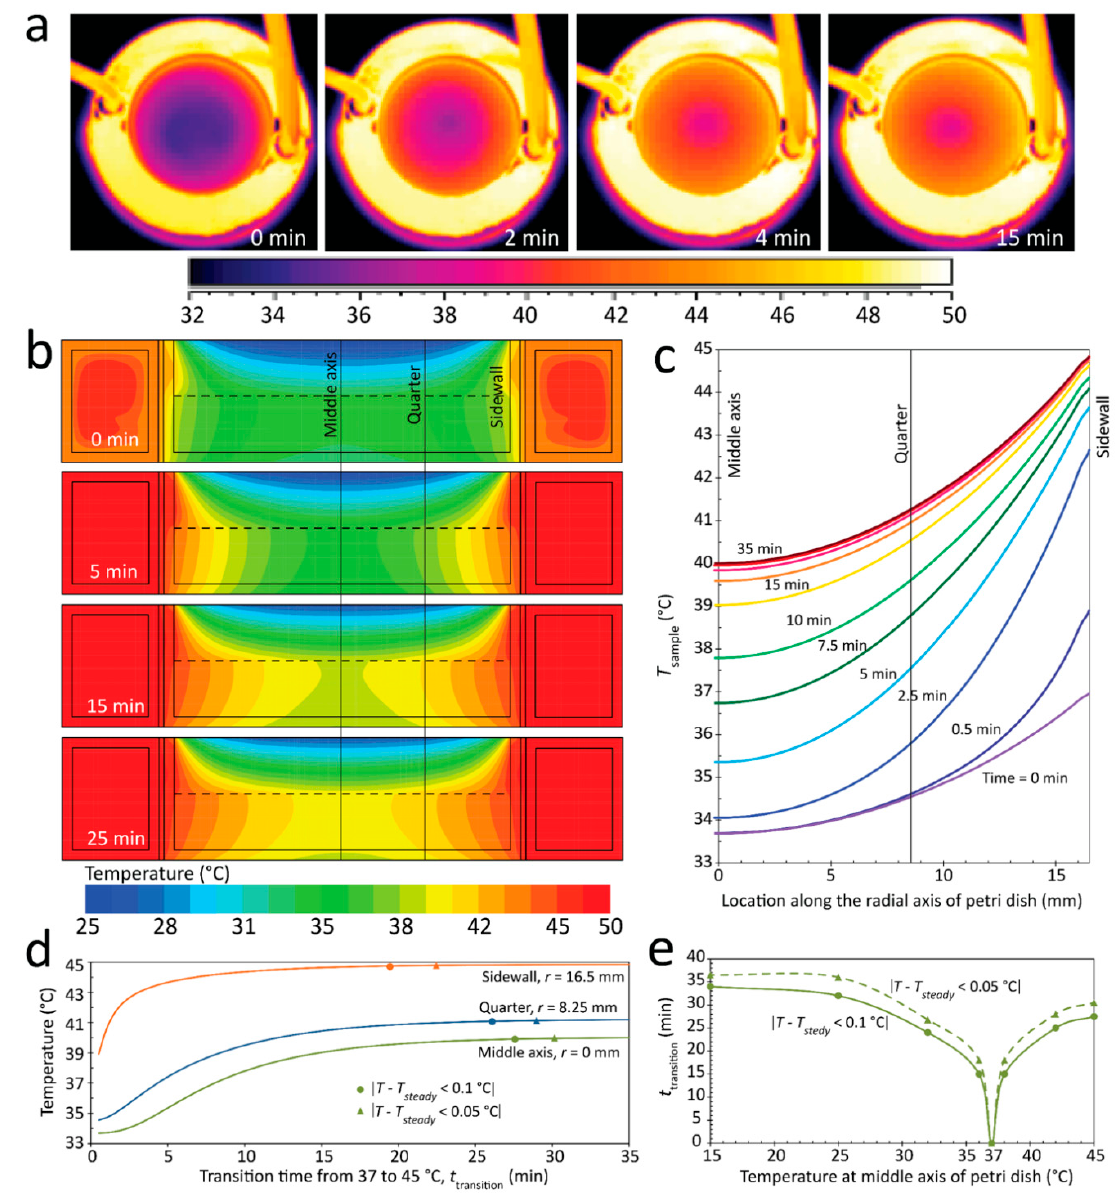
Figure 7. Analyzing the thermal performance of the water jacket system under transient conditions, corresponding to increasing sample temperature from 37 to 45 °C. ( a ) Temperature contours at the top free surface of the water jacket system obtained by thermal imaging camera. ( b ) Temperature contours at the middle cross-section of the system at 0.5, 5, 15, and 25 min after the increase in temperature. Results indicate a rapid change in temperature for water recirculating through the water jacket in contrast to the slow change in temperature for the sample inside the Petri dish. ( c ) Variation in temperature along the radial axis of the Petri dish at z = 1 mm and different time steps. The results indicate small temperature changes toward the end of the transition before the system reached its new steady state condition. ( d ) Temporal temperature changes along the sidewall, quarter, and middle of the Petri dish. The results indicate a rapid response of the sidewalls compared to the middle axis of the Petri dish. Circle ( • ) and triangle ( ∆ ) symbols show the transition period obtained from the following two criteria: (cid:3627)𝑇 − 𝑇 (cid:3046)(cid:3047)(cid:3032)(cid:3028)(cid:3031)(cid:3052) < 0.1°C(cid:3627) and (cid:3627)𝑇 − 𝑇 (cid:3046)(cid:3047)(cid:3032)(cid:3028)(cid:3031)(cid:3052) < 0.05°C(cid:3627) , respectively. ( e ) Variations in the transition period against the temperature change.